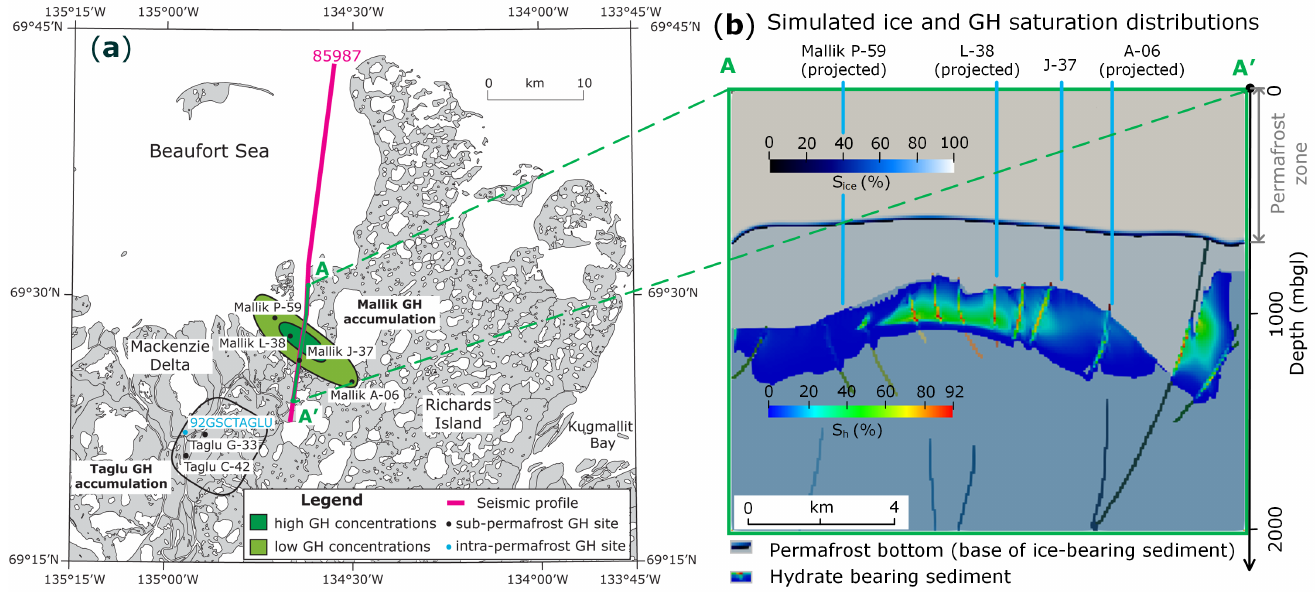
Figure 4. ( a ) Map illustrating the saturation distribution of seismic- and well-log-inferred Mallik GH accumulations in the outer Mackenzie Delta, modified after [45]; ( b ) simulated regional permafrost and sub-permafrost GH accumulation distributions after a simulation time of 1 Ma (cf. Figure 3 for modeling dimensions). ( a ) presented with permission from Natural Resources Canada under the Open Government License—Canada version